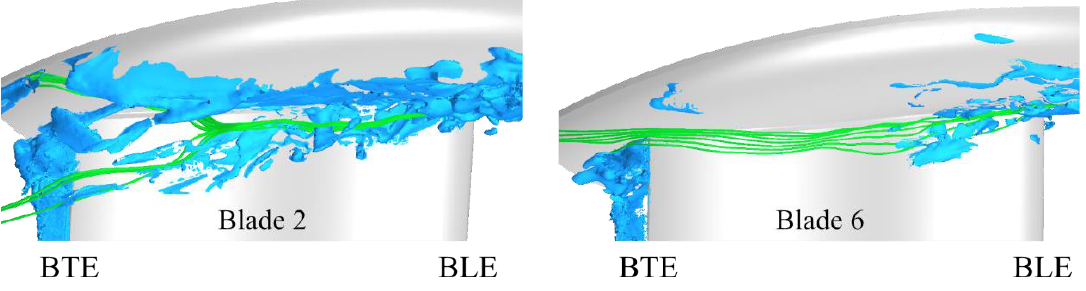
Figure 5. Iso-surfaces of the vorticity magnitudes at ‖𝜔⃗⃗ ‖ = 8000 𝑠 −1 (colored blue) and streamlines (colored green) emanating from the gap, being swept from the blade leading edge (BLE) to the blade trailing edge (BTE).